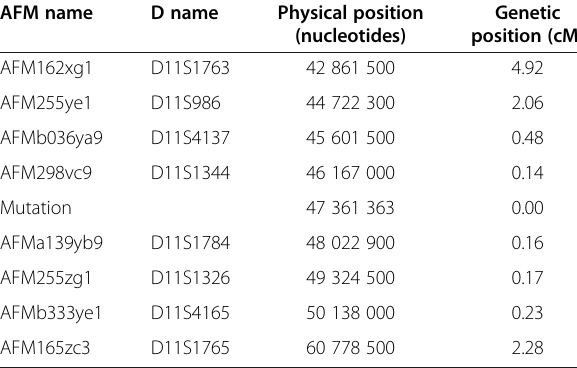
Table 3 Physical and genetic positions of the polymorphic markers flanking the MYBPC3 gene used in this